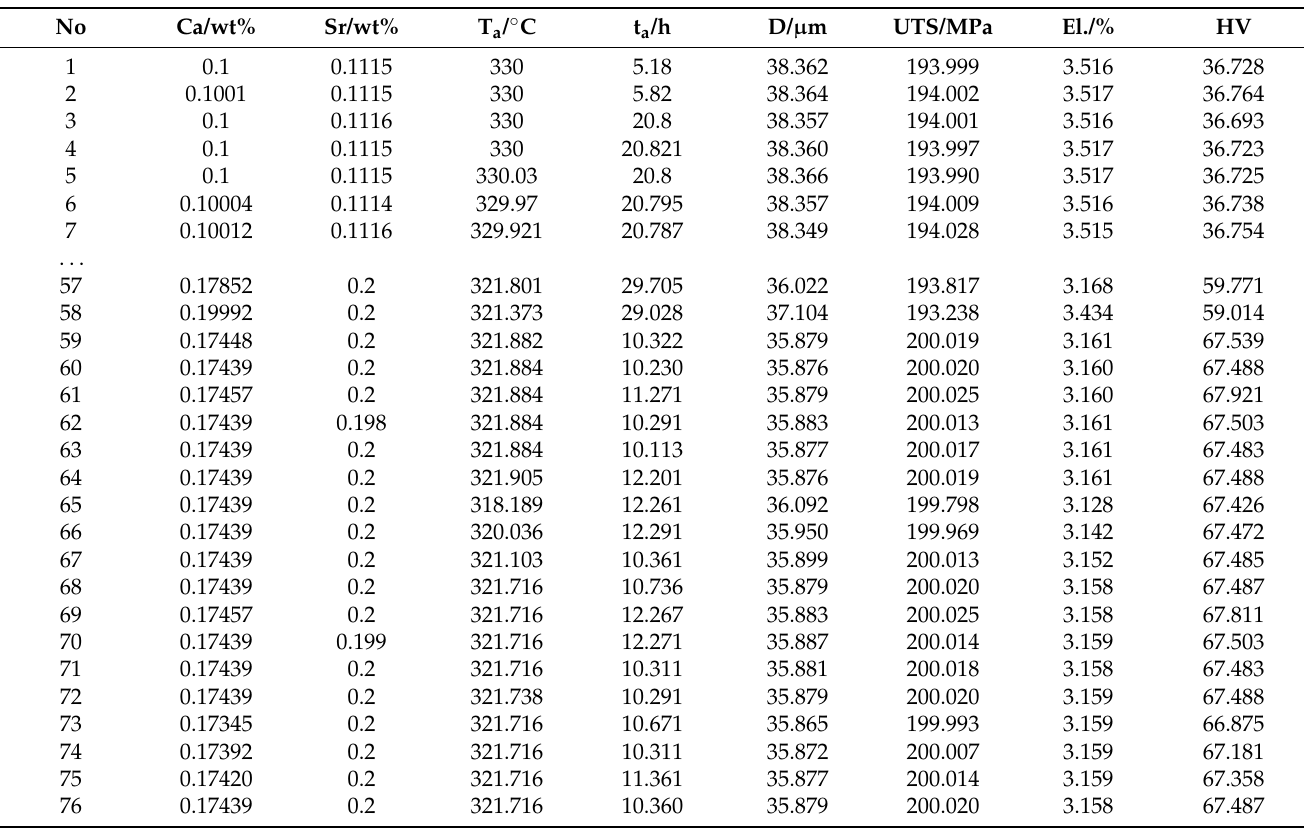
Figure 11. The calculation interface of Integrated Computing Platform. Table 5. Partial iterations of integrated optimization calculation.